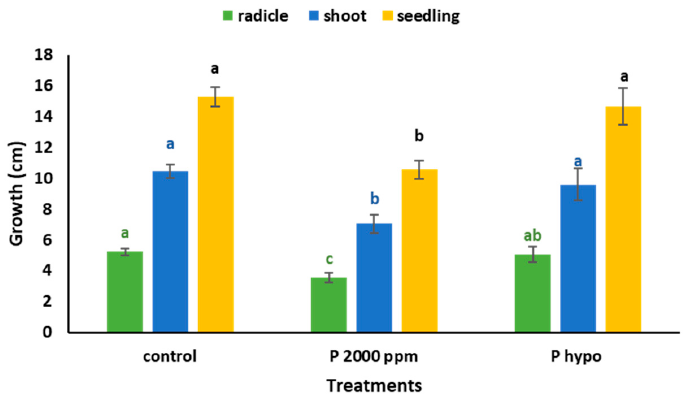
Figure 8. The growth response of the radicle, shoot, and seedling to two distinct fungal seed treatment procedures. Means are presented ±SD ( n = 100). At p < 0.05, values between treatments marked by different letters differ significantly. They began in order, with the letter (a) being the most significant.